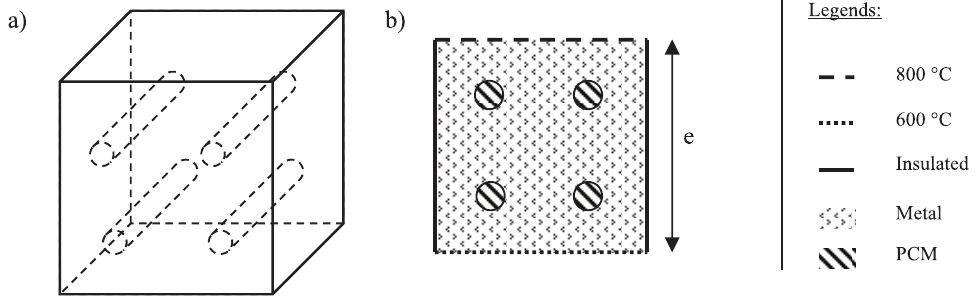
Fig. 3: Isometric view (a) and face view (b) of the TES model, subdomains and border